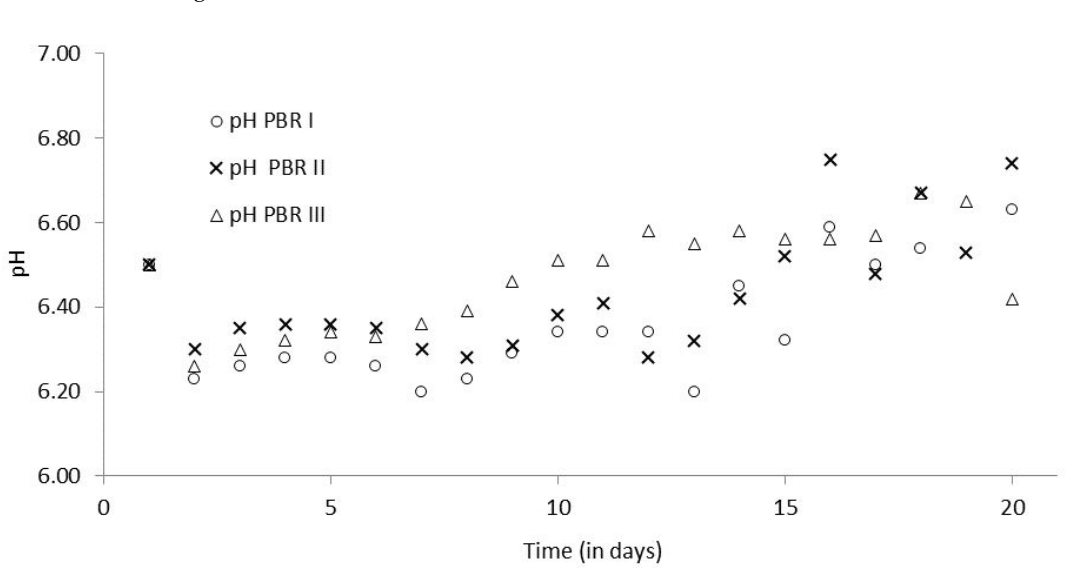
Figure 3. Distribution of acidity over time, depending on the type of lighting system. Source: own